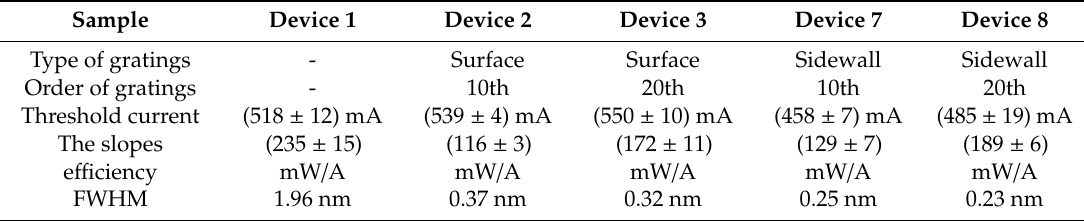
Figure 8. Light output power–current–voltage characteristics of Devices 1, 2, 3, 7, and 8 operated in pulsed mode with a 1 µs pulse width and a 10 kHz repetition rate. Table 3. Electrical properties of the fabricated DFB LDs and F–P LDs.